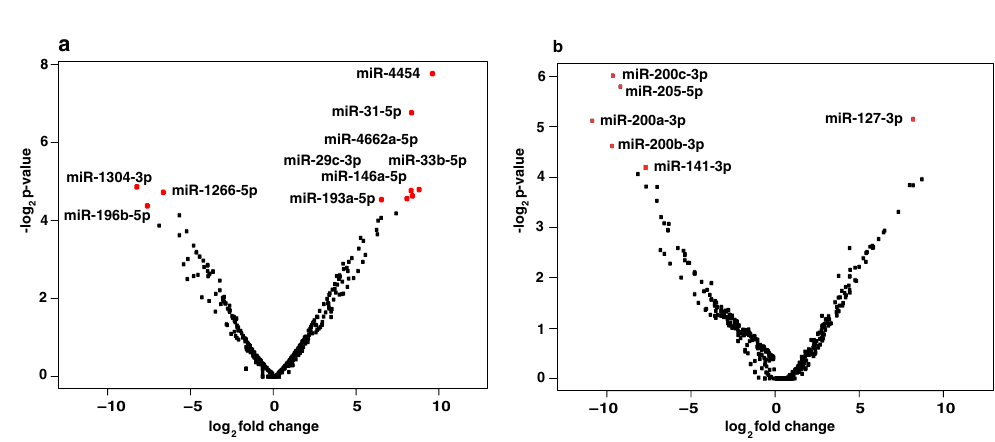
Figure 3. A volcano plot showing distribution of miRNAs in ( a ) OKF6/TERT1- Tobacco cells ( b ) OKF6/ TERT1-Smoke cells. The red dots represent significantly dysregulated miRNAs (p-value ≤